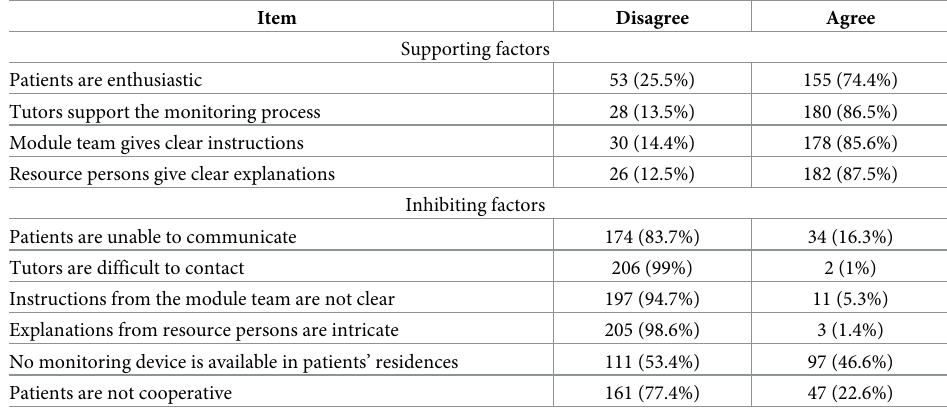
Table 6. Supporting and inhibiting factors in monitoring patients up to week 4 (N = 208). Item